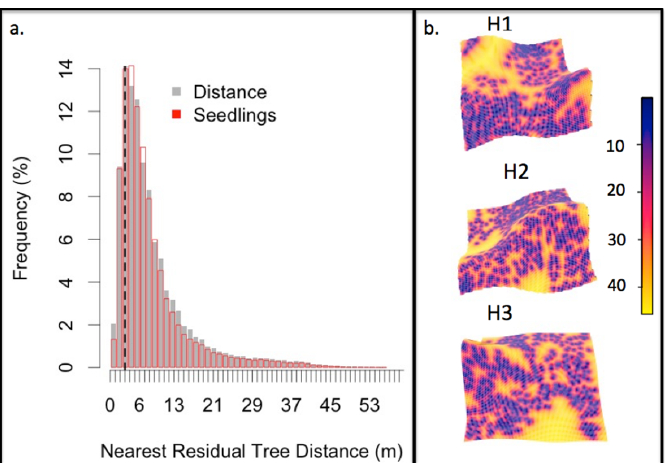
Figure 7. ( a ) The distributions of all post ‐ fire regeneration (red) and nearest residual tree distance (gray) within plots by nearest residual tree distance (m) in the Hayman Fire. The vertical black line marks distances under canopy cover; ( b ) Post ‐ fire perspective plots where the height of the plot represents the density of post ‐ fire regeneration and the color indicates the distance to the nearest residual tree (m) for each 4 ‐ ha plot (H1, H2, and H3).